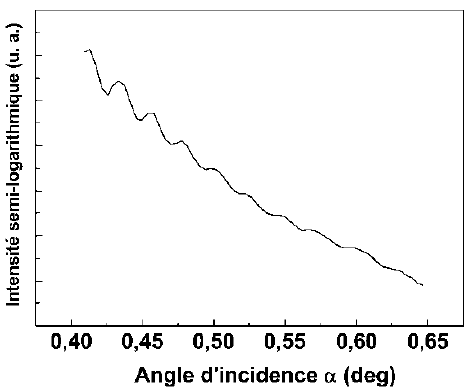
FIGURE 2b Variation semi-logarithmique de l’intensite´ re´fle´chie spe´culairement en fonction de l’angle d’incidence a de l’e´chantillon TiO 2